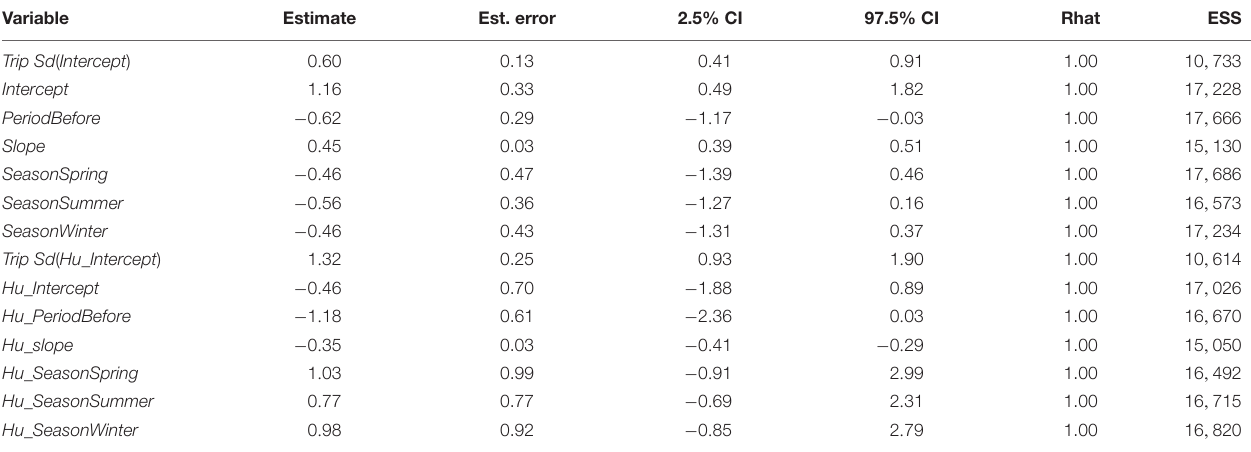
TABLE 4 | Results from the biomass hurdle model with the lowest Widely Applicable Information Criterion (WAIC): Period + Slope + Season + Trip . Variable Estimate Est. error